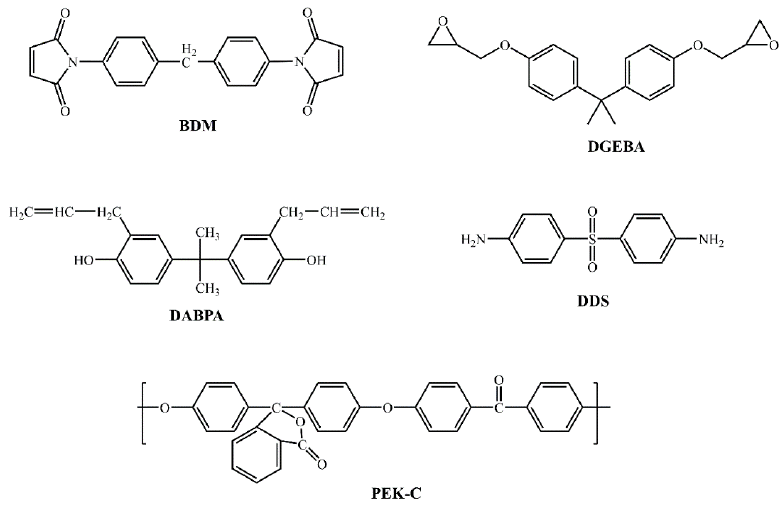
Figure 1. Chemical structures of adhesive components.